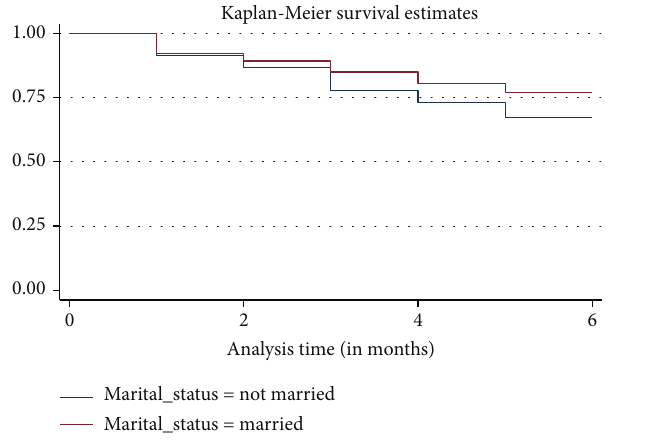
Figure 1: Survival function (Kaplan-Meier survival